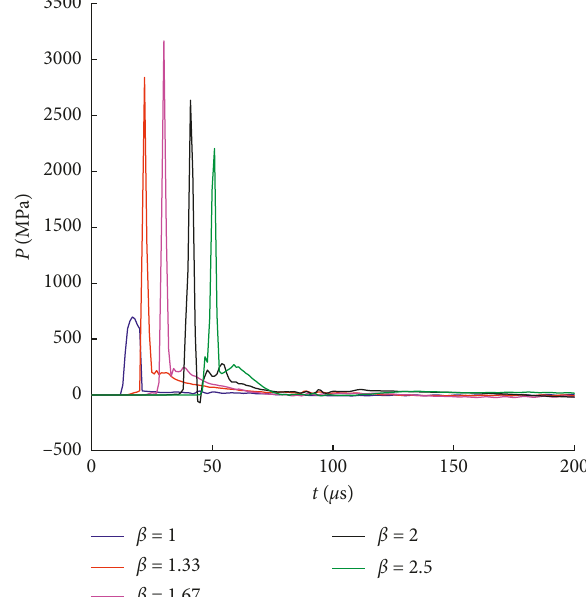
Figure 9: The curve of stress of coal element in direction of concentrating energy at the wall varying with the time ( β is the radial decoupling